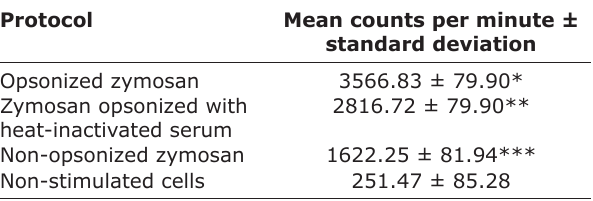
Table-3: Comparison of luminol-dependent CL response of camel PBL with opsonized zymosan, zymosan opsonized with heat-inactivated serum, non-opsonized zymosan, and non-stimulated cells.